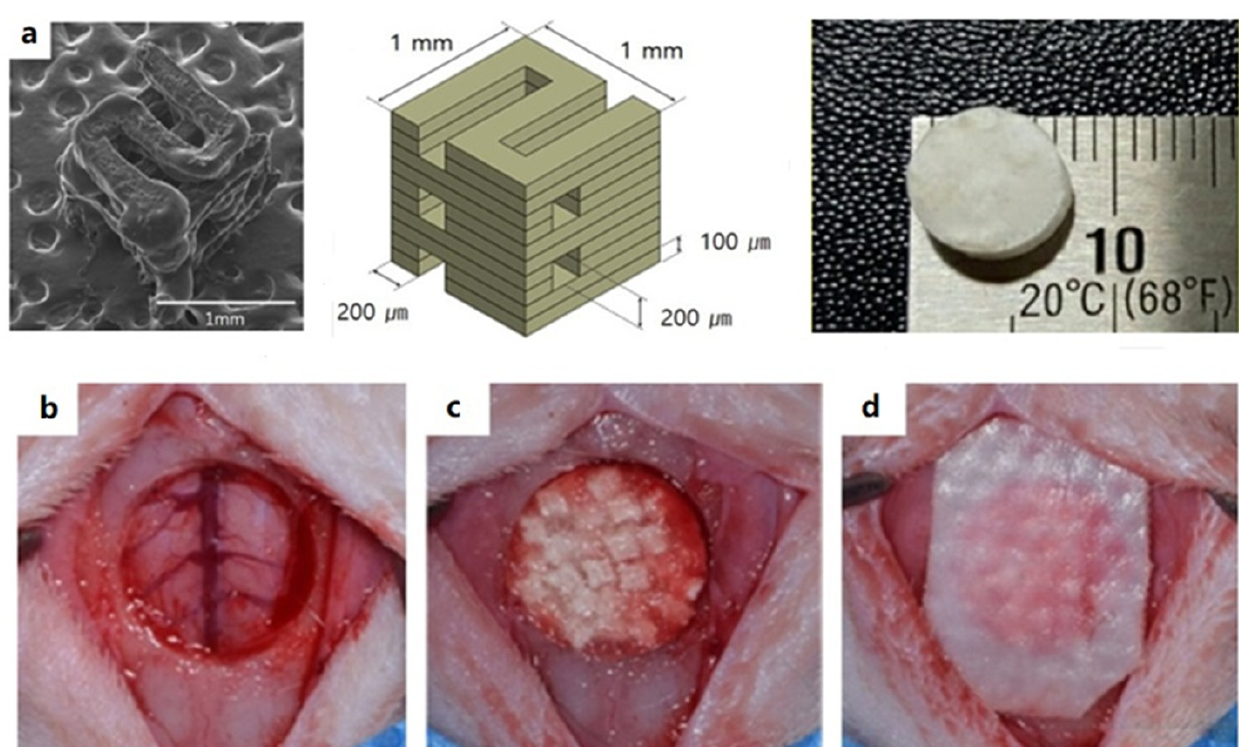
Figure 1. Bone defect repair model based on PCL/PLGA/ β -TCP scaffolds: ( a ) SEM image and PCL/PLGA/ β -TCP scaffold simulation structure; ( b ) porous bone defect structure (8 mm-diameter); ( c ) defect area filled with PCL/PLGA/ β -TCP composite bone graft; ( d ) defect area filled with colla- gen membrane [34].